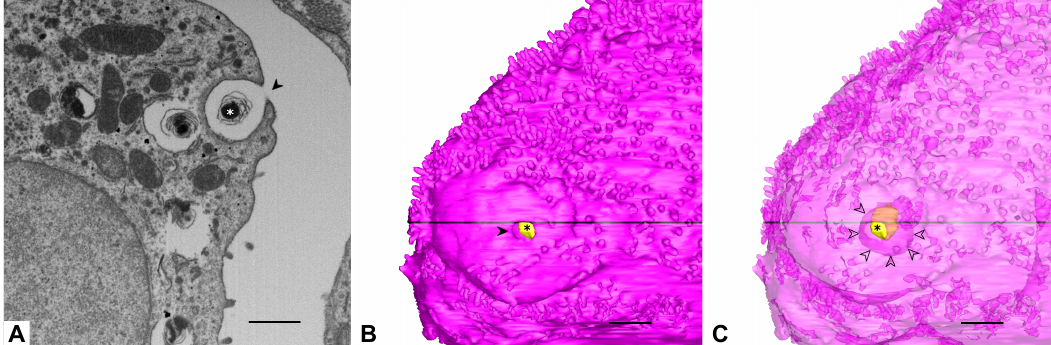
Figure 2. Luminal AE2 cell surface and surfactant secretion pore. ( A ) Detail from image 884 which shows an open surfactant secretion pore (arrowhead) and remnants of a lamellar body inside (asterisk). In this image the opening is much smaller than the profile diameter of the vesicle under secretion. ( B ) 3D model of the AE2 cell with the secretion pore (arrowhead) and the remnants of the lamellar body inside (yellow, asterisk). Note the plain cell surface in this area. ( C ) Same image content as in B but with a transparent cell body, which reveals the entire remnant of the lamellar body and indicates the size of the secretory vesicle (circumference marked by arrowheads), the projection of which is much larger than the secretion pore. Scale bars: 1 µ m. The black lines in B and C indicate the position of the section plane of